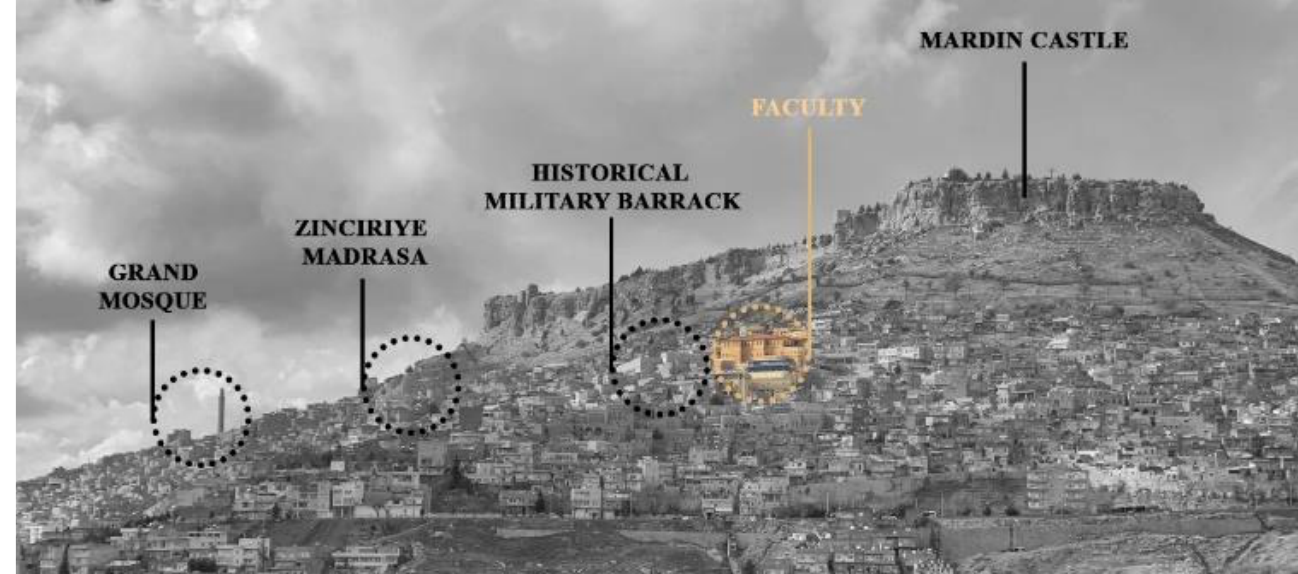
Fig. 14. Faculty building in historical Mardin city [photograph by authors,